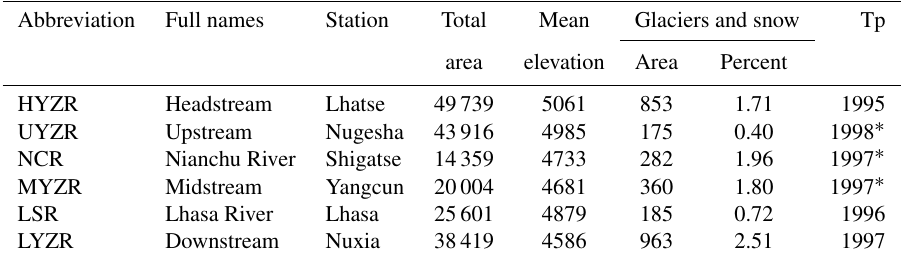
Table 1. Information of six basins divided according to the locations of hydrological stations. The column Tp indicates the turning point, calculated using the Pettitt method, in which a significant turning point is labeled with an asterisk ∗ . Glaciers and snow coverage are derived from the land use and cover data in 2000 (see Sect. 2.2). The unit of area is kilometers squared (km 2 ), and the unit of elevation is meters (m).